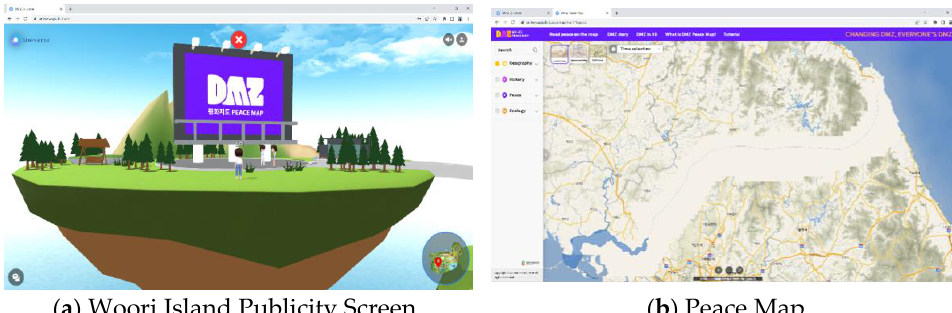
Figure 12. Public Relations Space.